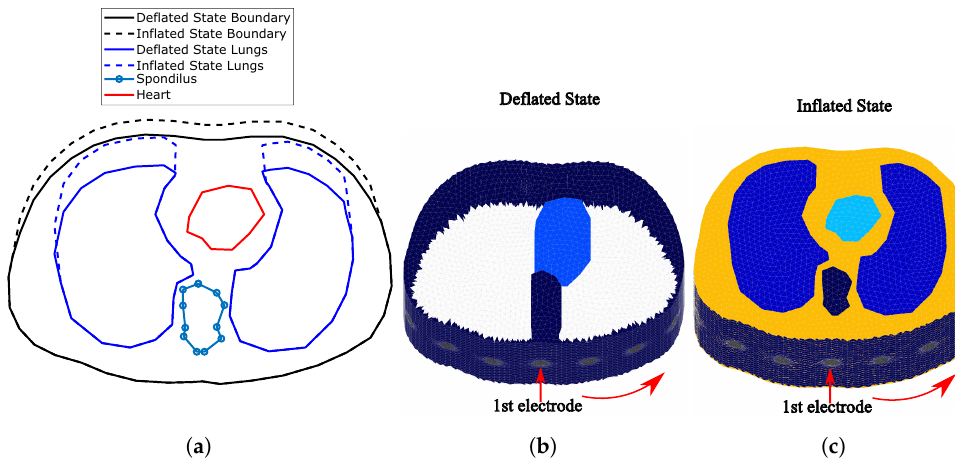
Figure 2. ( a ) Cross-section of the F.E. thoracic model boundaries and tissues simulated for the deflated and inflated states. (The deflated state is based on an adult male CT image.) ( b ) Fine thoracic F.E. model for the deflated case (the lungs are not visible since their conductivity is similar to the background’s one). ( c ) Fine thoracic F.E. model for the inflated case. The lungs’ conductivity is significantly lower than the background’s one. In both ( b , c ) cases, the skin has been included.